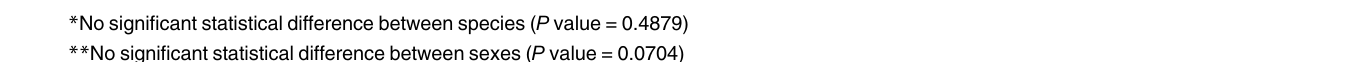
The results of univariate modeling of space and substrate variables on MS scores are pre- sented in Table 3, and were used to guide development of the multivariable model. Descriptive statistics detailing the variables included in the multi-variable regression model are shown in Table 4. In the multivariable multinomial logistic predictive model, the combination of time on hard substrate, Space Experience in environments that included both indoor and outdoor areas, and the interaction of Space Experience In/Out Choice with age had the most effect on odds of increased MS scores (Table 5). The odds ratio for percent time spent on hard surfaces was 1.050. An example of how this odds ratio associates time on hard substrates with MS scores is illustrated using population-level descriptive statistics for time on hard substrates. Elephants that spend 4 hours per 24 hour period on hard substrates (population 3 rd quartile) are 68% more likely to have a MS score of 2 (versus 1) than are elephants which spend 2.5 hours per 24 hour period on hard substrates (population mean). Space Experience for areas with a choice of indoors or outdoors is associated with a 3.7% increase in odds of a higher MS score. However, this effect is attenuated by age, such that for each year an elephant ages, the effect of Space Experience In/Out Choice on MS score decreases by 0.1%.